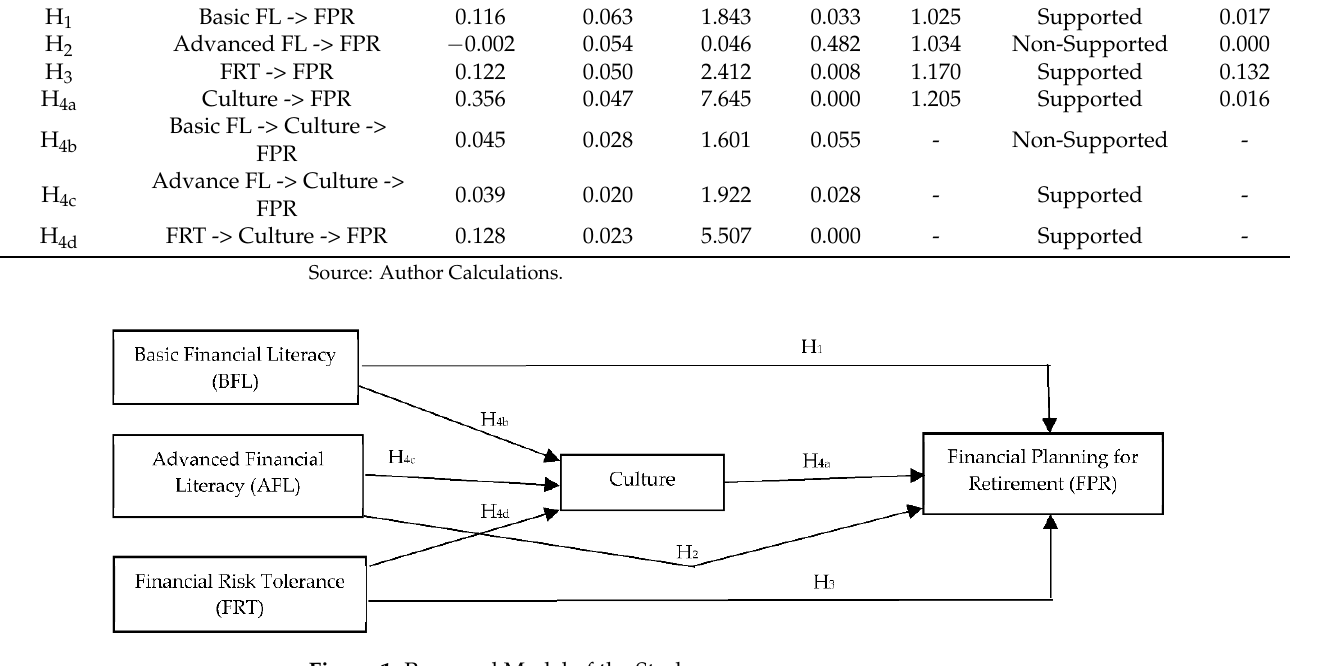
Figure 1. Proposed Model of the Study.